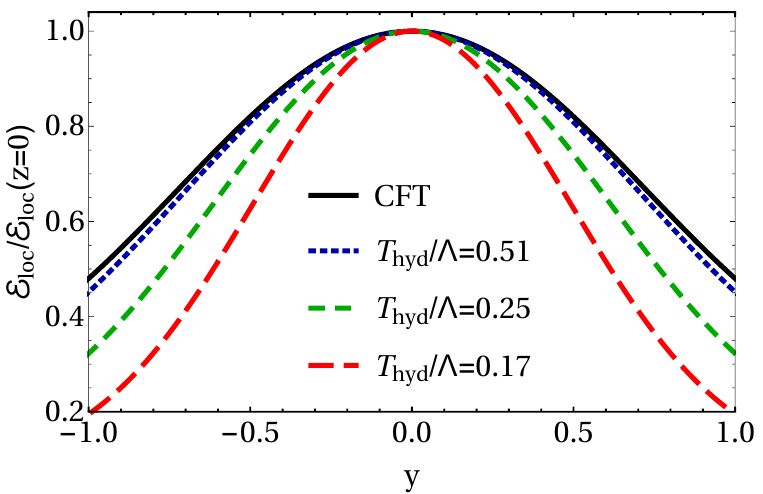
Figure 15 . Rapidity distribution of E loc at (cid:12)xed proper time (cid:28) = t hyd , with t hyd the hy- drodynamization time at z = 0 in the (cid:30) (cid:22)= (cid:3) = f 0 : 29 ; 0 : 77 ; 1 : 9 g .